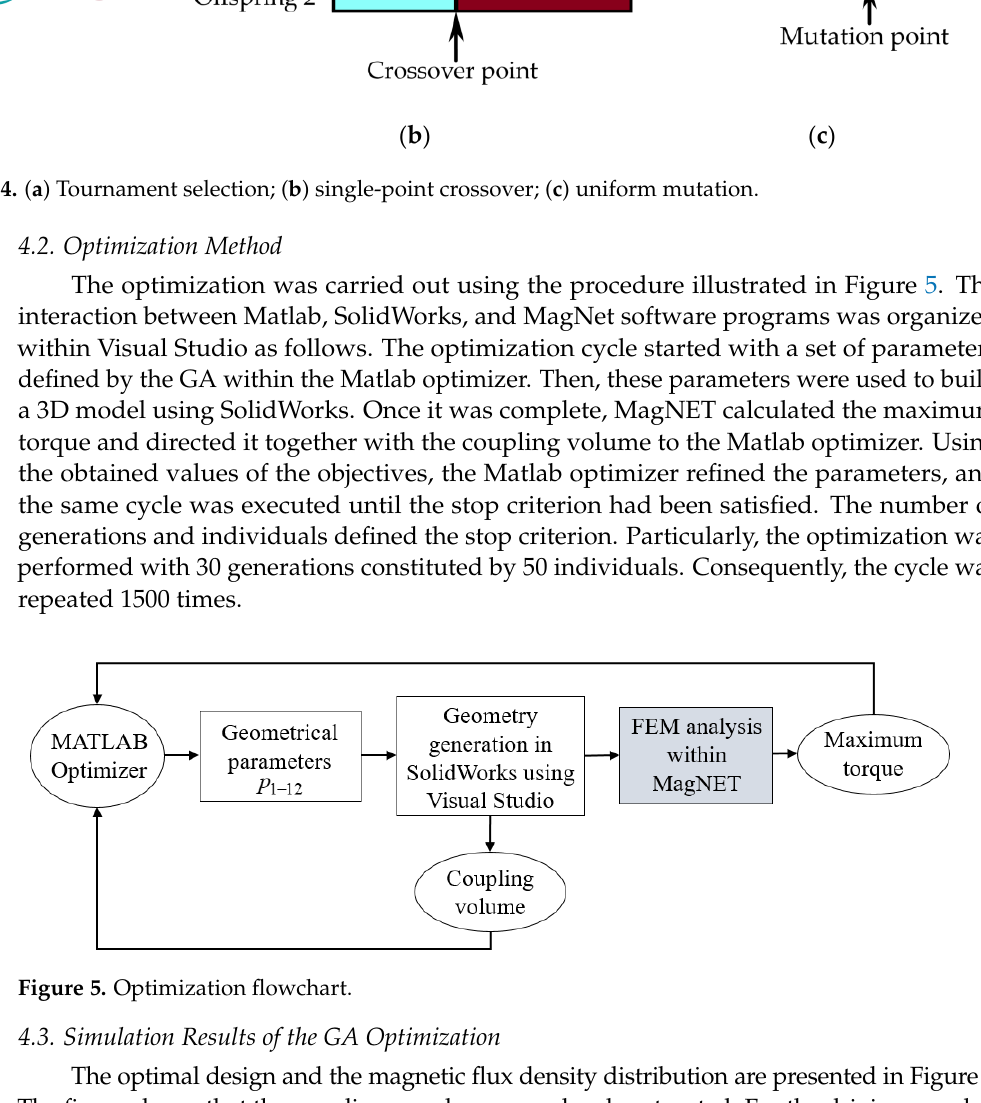
Table 2. Simulation results of genetic algorithm (GA) optimization.